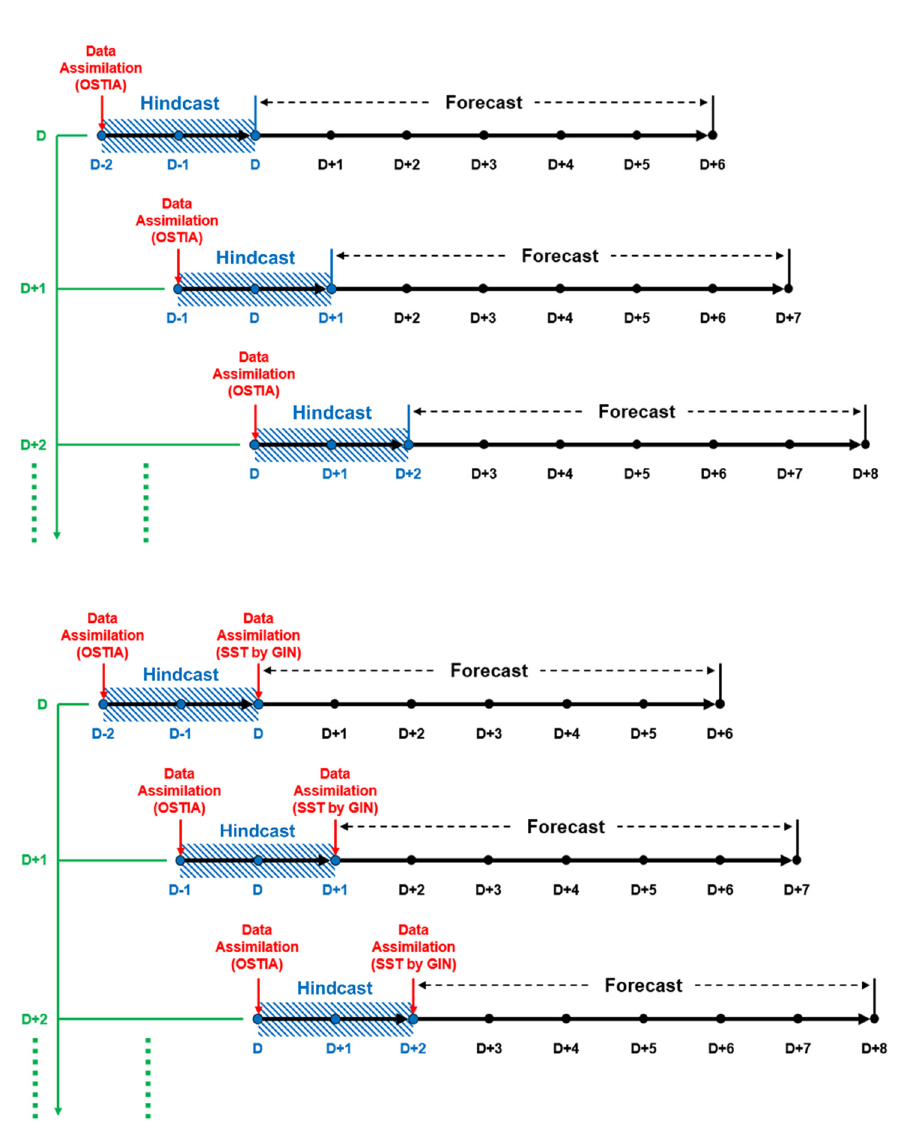
Figure 1. The timeline of the forecasting systems. The ( top ) is the control run (CTRL), and the ( bottom ) is the GIN case (WGIN), respectively.